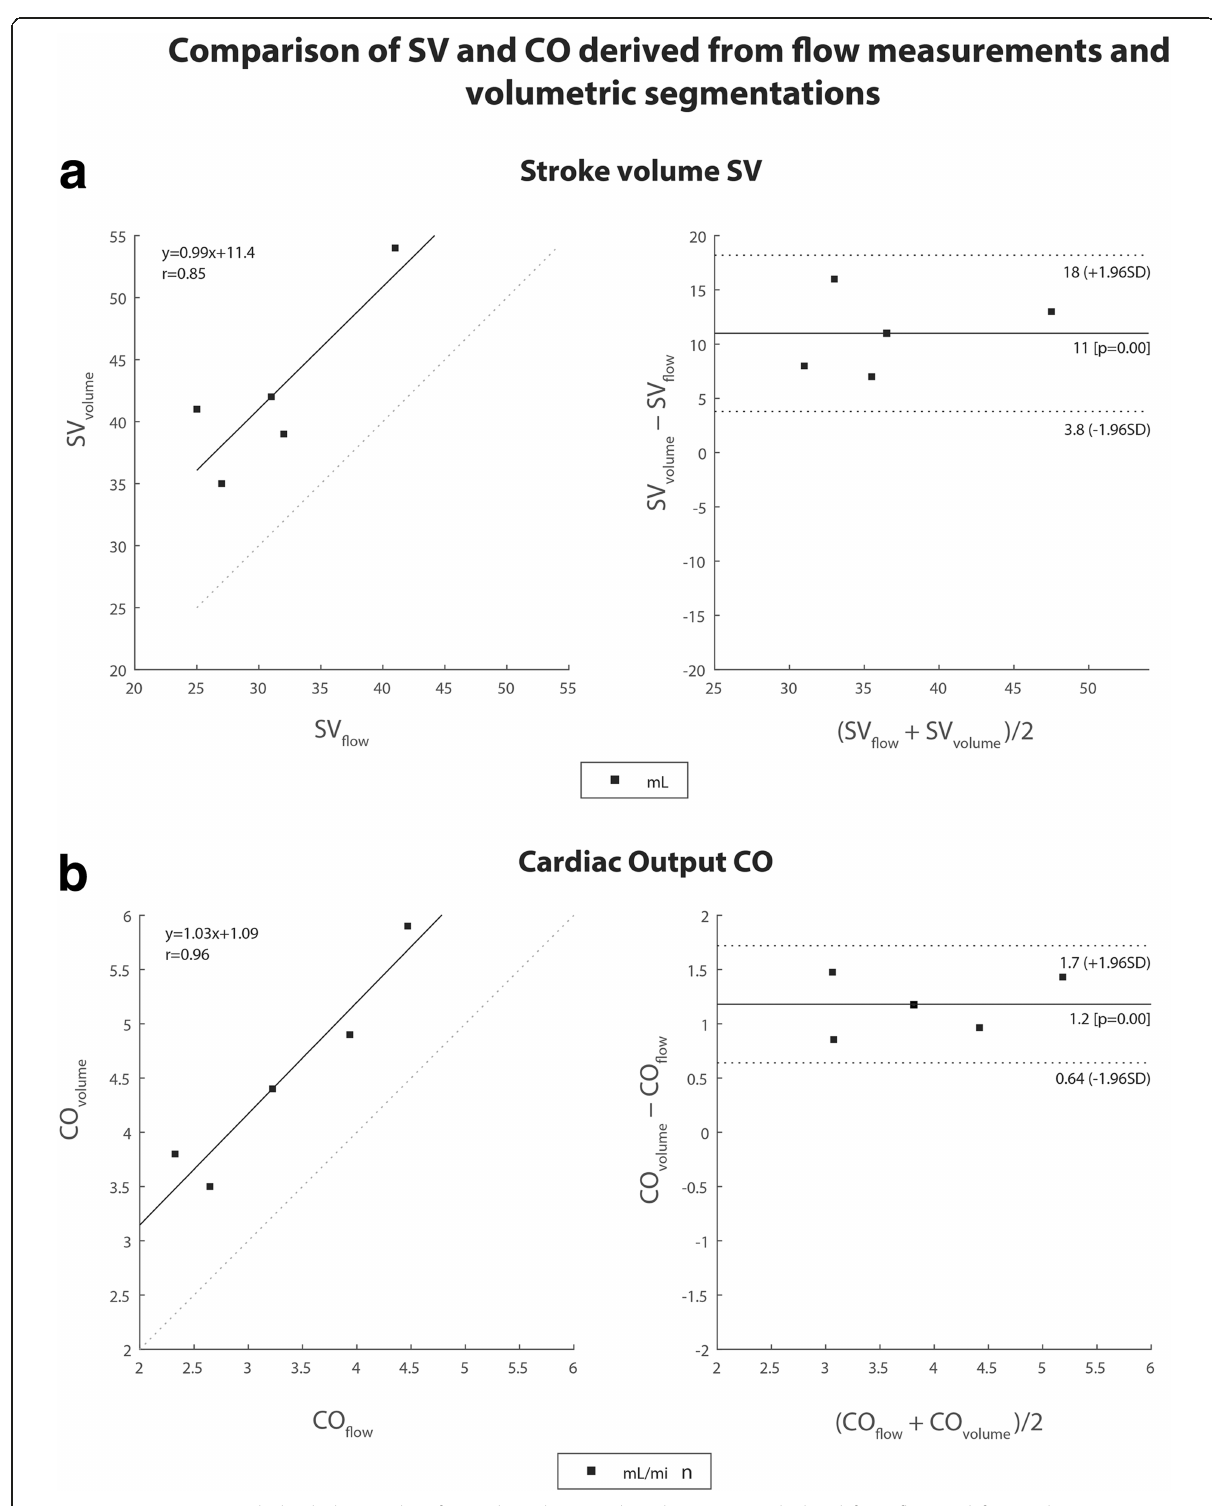
Fig. 4 Linear regression and Bland-Altman plots for stroke volume and cardiac output calculated from flow and from volumetric measurements. Comparison of the two techniques used for cardiac output (CO) and stroke volume (SV) estimation using Bland-Altman analysis. a Linear regression and Bland-Altman plots for SV calculated from aortic flow data (SV flow ) and from left ventricle (LV) volume (SV volume ). b Linear regression and Bland-Altman plots for CO calculated from aortic flow data (CO flow ) and from LV volume (CO volume